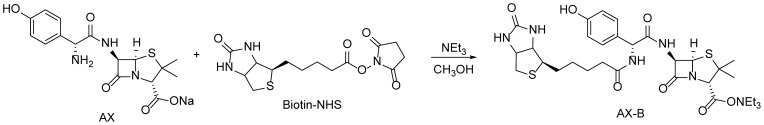
Synthetic procedure for AX-B.